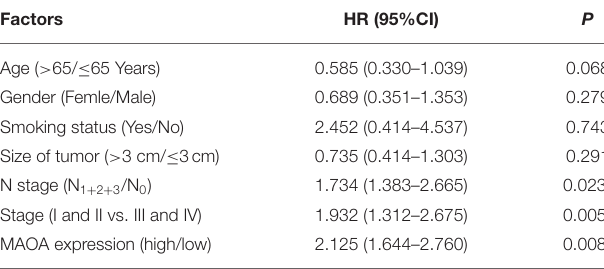
TABLE 2 | Multivariate analyses of MAOA expression and other clinical prognostic factors in 108 patients with LUAD.